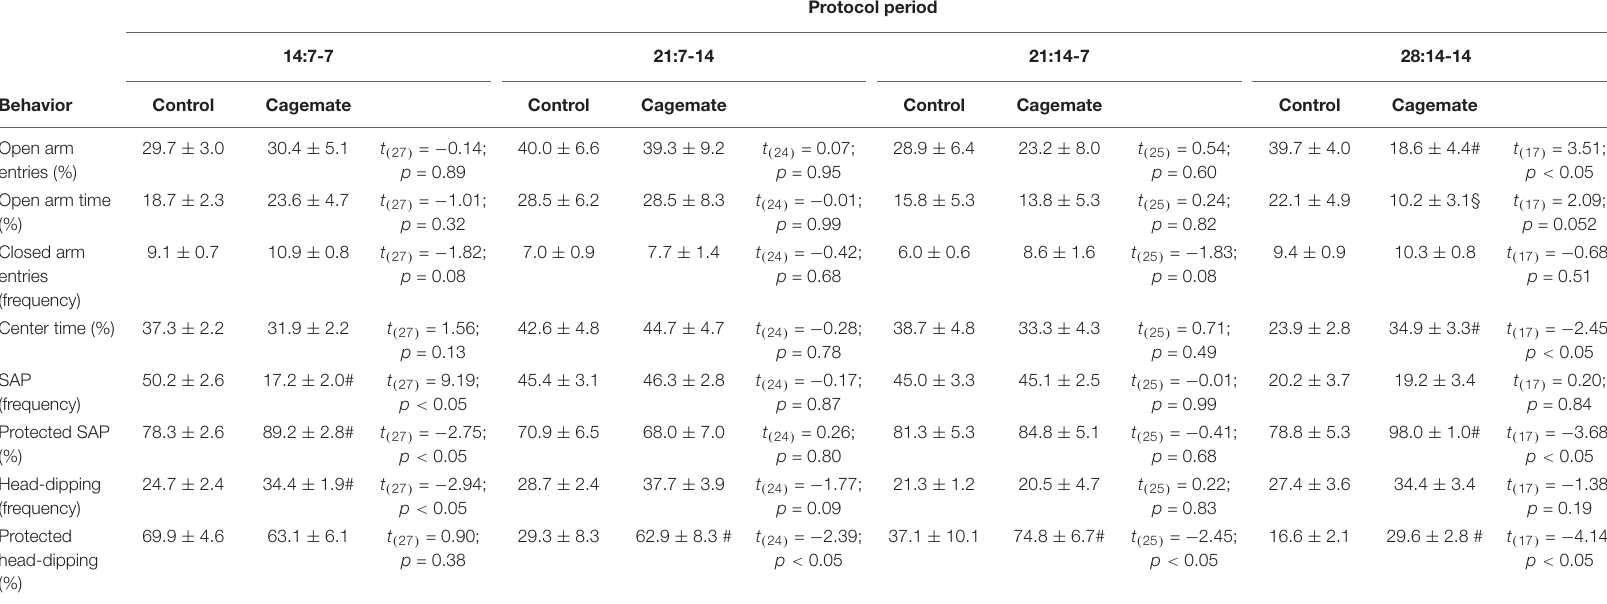
TABLE 2 | Student’s t -test for anxiety-like behavior evaluated in the elevated plus